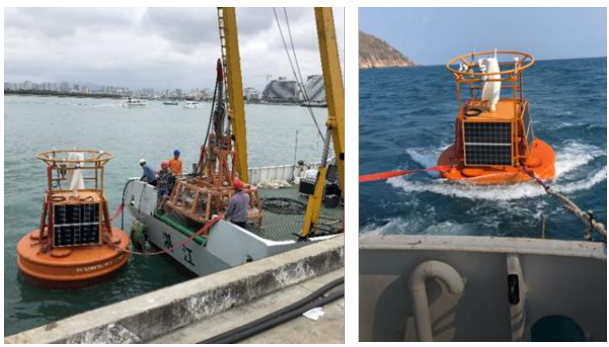
Figure 22. Towing the buoy to the area of deployment. J. Mar. Sci. Eng. 2020 , 8 , x FOR PEER REVIEW